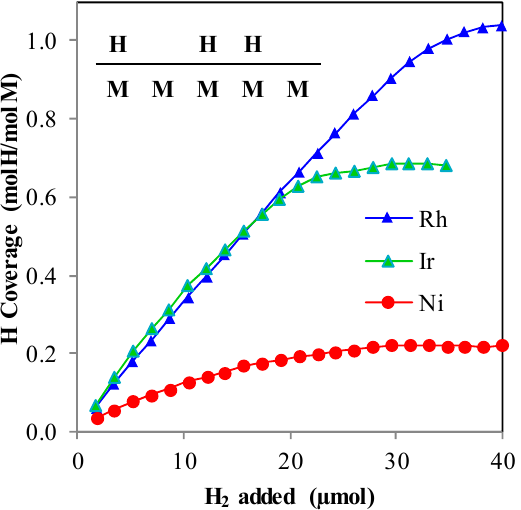
from metal particle sizes revealed by the STEM imaging (2 nm, 1 nm, and 7 nm for the Rh, Ir, and Ni, respectively) [20,21]. The H 2 adsorption data presented in Figure 2 was calculated as H-coverage evolution (mol H / mol Msurf, M= Rh, Ir, Ni) for accumulated H 2 added (by pulses) into the adsorption cell (µmol). These adsorption results indicate that bare Rh and Ir surfaces adsorb H 2 completely until saturation, which is indicated by the inflexion point and the asymptotical part of the plots (after adding ~40 and ~20 mmol of H 2 , respectively). Saturation is reached at coverages of H-M surf of 1 and 0.7 for Rh, and Ir, respectively, which indicates a surface stoichiometry of 1:1 (H:Rhs urf ) and 0.7:1 (H:Ir Surf ). In the case of Ni, the adsorption pattern is dissimilar in three main aspects: 1) H-uptake is low (0.2 mol H /mol Nisurf ) compared to Rh or Ir, 2) there is no clear inflexion point for the adsorption curve, and 3) the calculated stoichiometry H-Ni surf is low (only 20% of surface nickel atoms adsorb hydrogen). H 2 -uptake at 800 °C is lower compared to the uptake at 600 °C (data shown Figure S2). At 800 °C, hydrogen saturates the metal surfaces at 1:1 (Rh), 0.5:1 (Ir), and 0.08:1 (Ni). Figure 2. Hydrogen surface saturation curves over MgAl 2 O 4 -supported Rh (blue), Ir (green), and Ni (red) catalysts at 600 ◦ C. Coverage was calculated using accumulated H 2 -uptake and metal dispersion data obtained from STEM imaging (Table 1). 50 mg of catalyst was calcined before analysis and reduced at the conditions used in the catalytic experiments (16 h at 850 ◦ C, 100 mL / min, 10% H 2 in N 2 ). H 2 was pulsed using a 100 µ L gas loop.